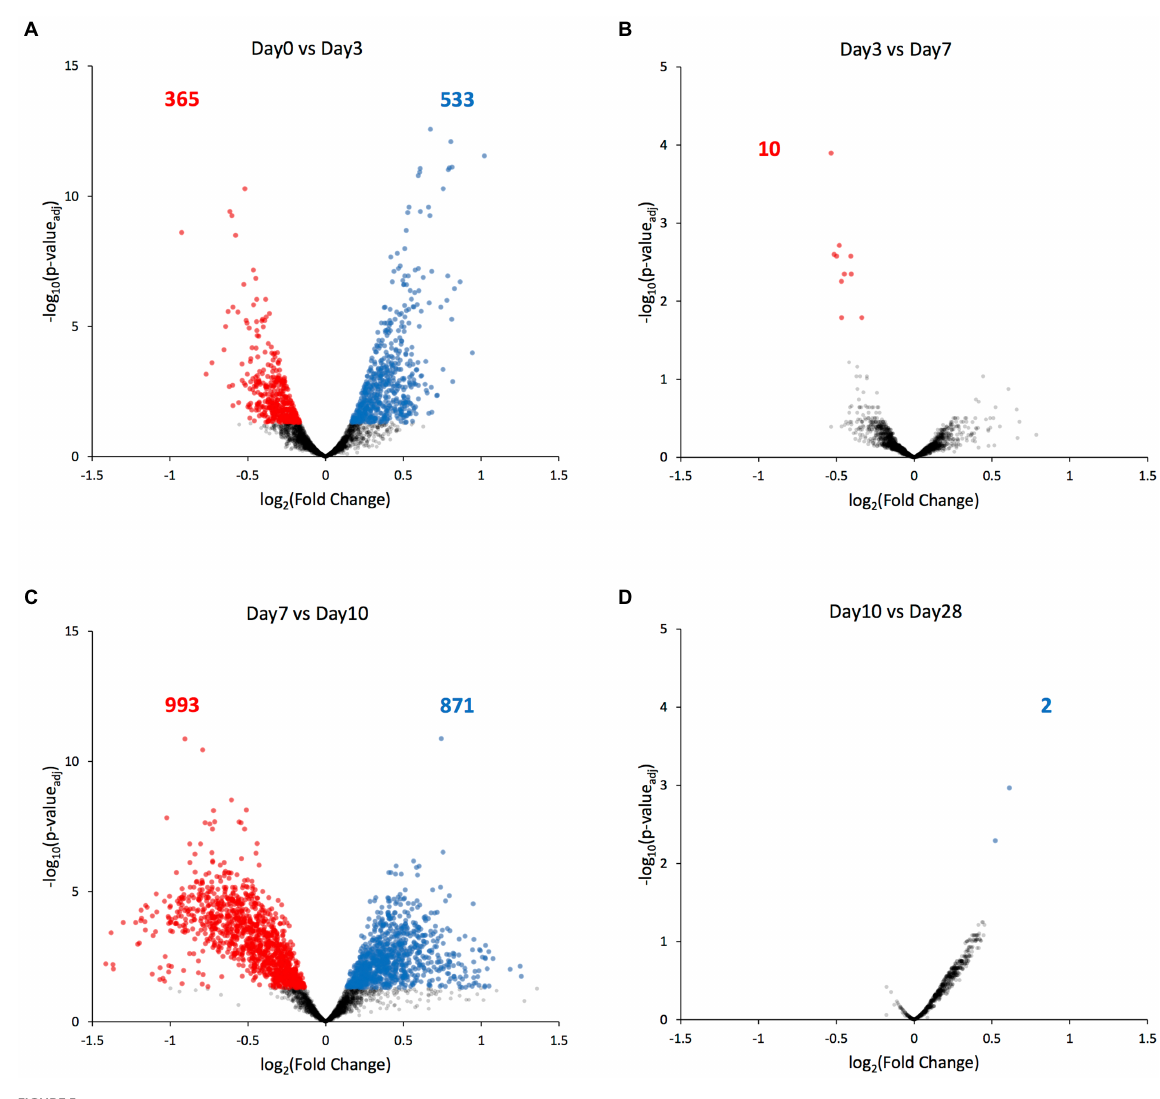
FIGURE 5 Genes with differentially compacted chromatin between consecutive time points. (A–D) Volcano plots comparing each ATAC-seq peak’s value at consecutive time points as a log 2 fold-change. Significantly differential peaks ( p adj < 0.05) are plotted either in blue (if increased in the latter time point) or in red (if increased in the former time point). The blue and red numbers indicate the number of genes with significantly altered chromatin compaction between each time